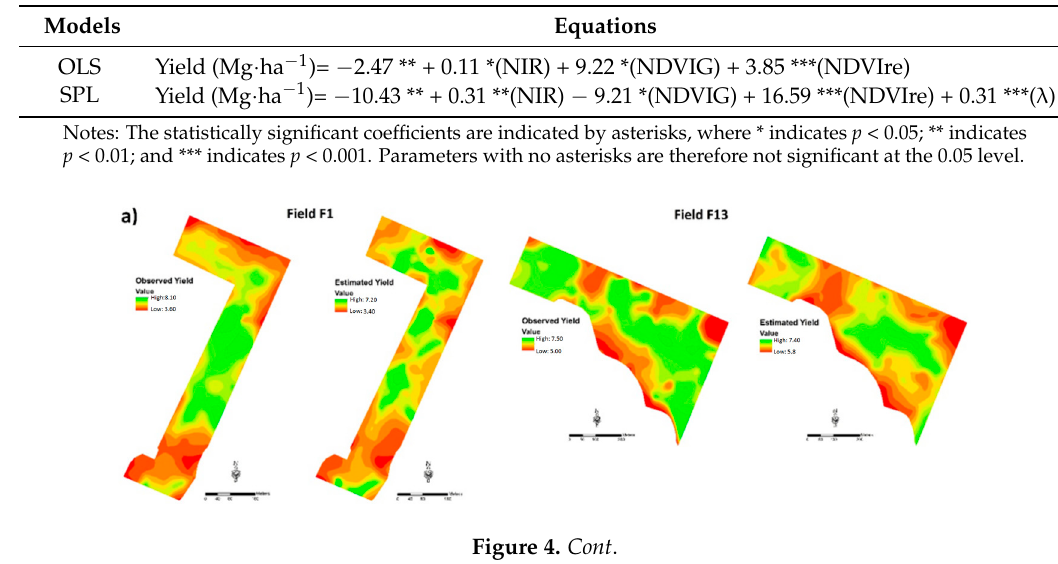
Table 5. Meta-functions for the ordinary least-square (OLS) and spatial econometric (SPL) models including the vegetation indices (VIs) obtained from mid-season high-resolution satellite imagery as predictors of the end-season yield monitor data, observed corn yield for all fields evaluated in this study.